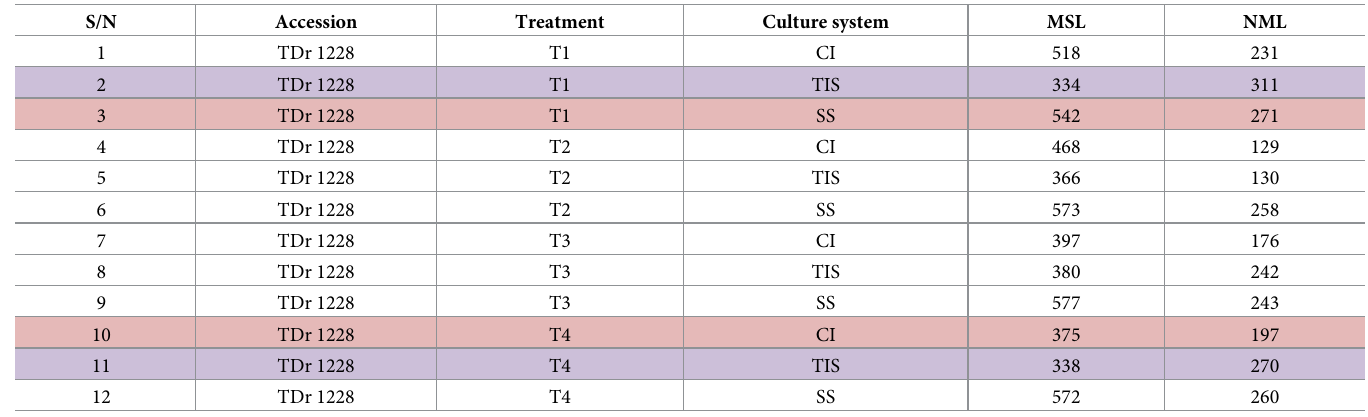
Table 5. Summary of band pattern of in vitro Dioscorea rotundata